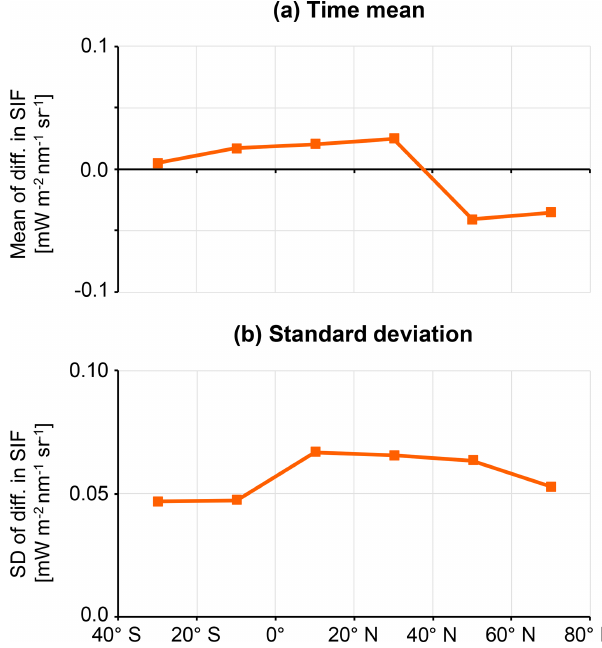
Figure 8. The monthly mean value shown in Fig. S16 is averaged over the target time period (February 2015 to January 2018): (a) av- eraged value; (b) standard